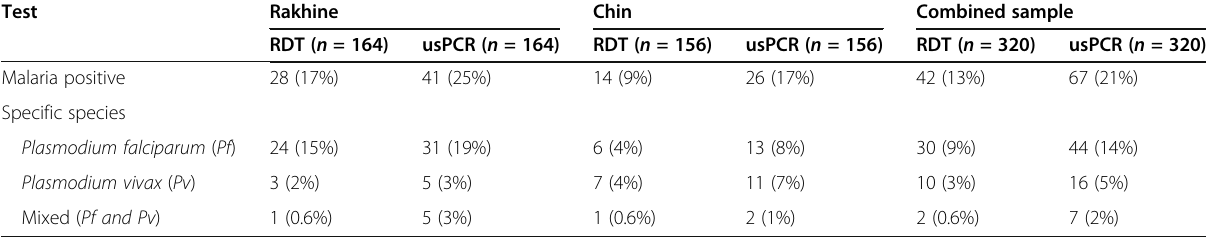
Table 1 Malaria positivity rate determined by RDT in two national groups, Myanmar (2016-2018) Test